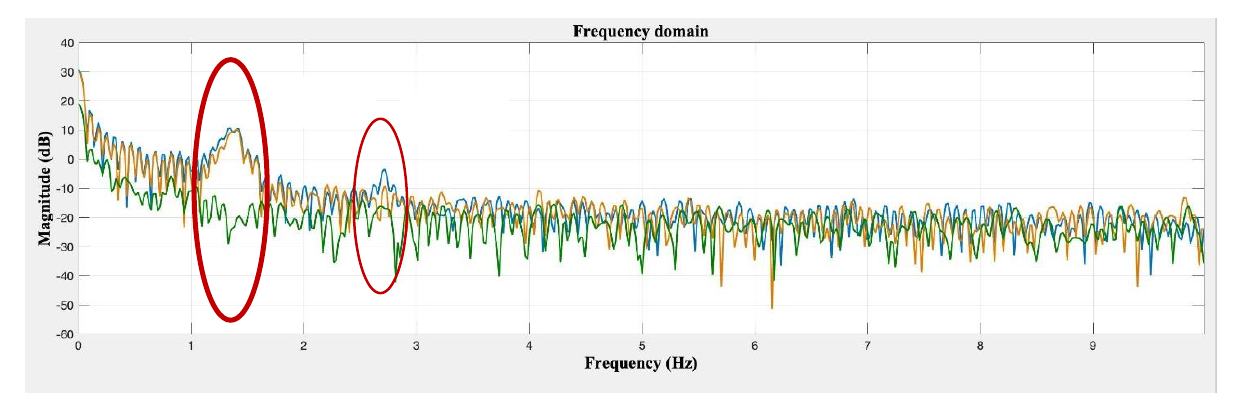
Figure 12 – DIC analysis’s results, Overall view and tendency